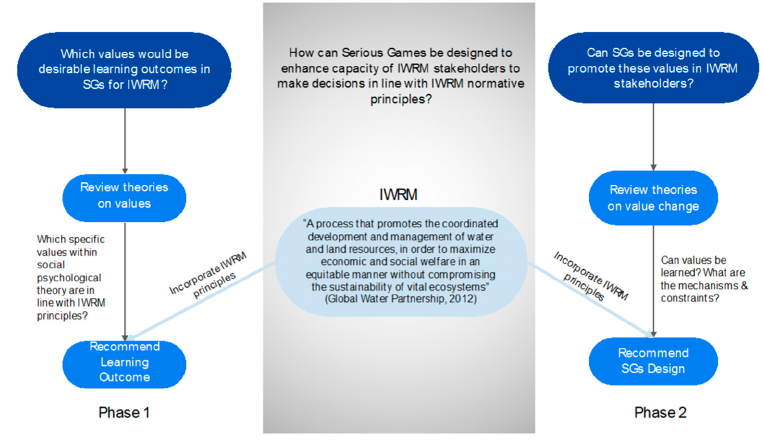
Figure 2. Overall methodology to answer the following research question: how can serious games be designed to enhance the capacity of IWRM stakeholders to make decisions in line with IWRM normative